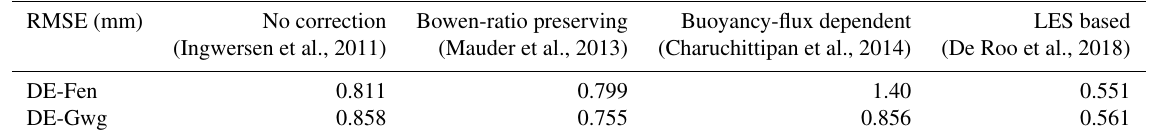
Figure 10. Comparison of daily evapotranspiration (ET) estimates based on eddy-covariance measurements after different variants of energy balance closure correction with daily ET estimates based on lysimeter measurements for the DE-Fen dataset. Table 1. Comparability or root-mean-square error (RMSE) of the different daily ET estimates (in mm) for the different SEB closure correction